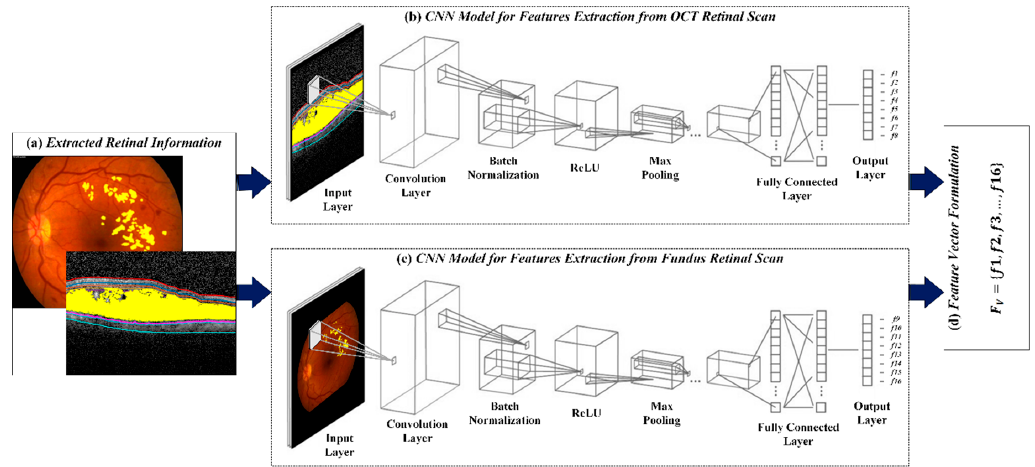
Figure 7. CNN for feature extraction. ( a ) Overlaid retinal scans with ME pathological symptoms; ( b ) CNN model for feature extraction from OCT retinal scans; ( c ) CNN model for feature extraction from retinal fundus scans and ( d ) 16-D feature vector containing eight OCT ( f 1 , f 2 , ... , f 8 ) and eight fundus features ( f 9 , f 10 , ... , f 16 ). Table 3. Proposed structure tensor influenced CNN